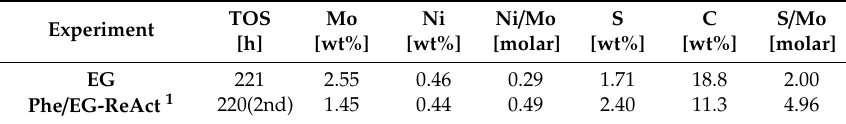
Table 2. Composition of the spent catalyst after long term experiments.